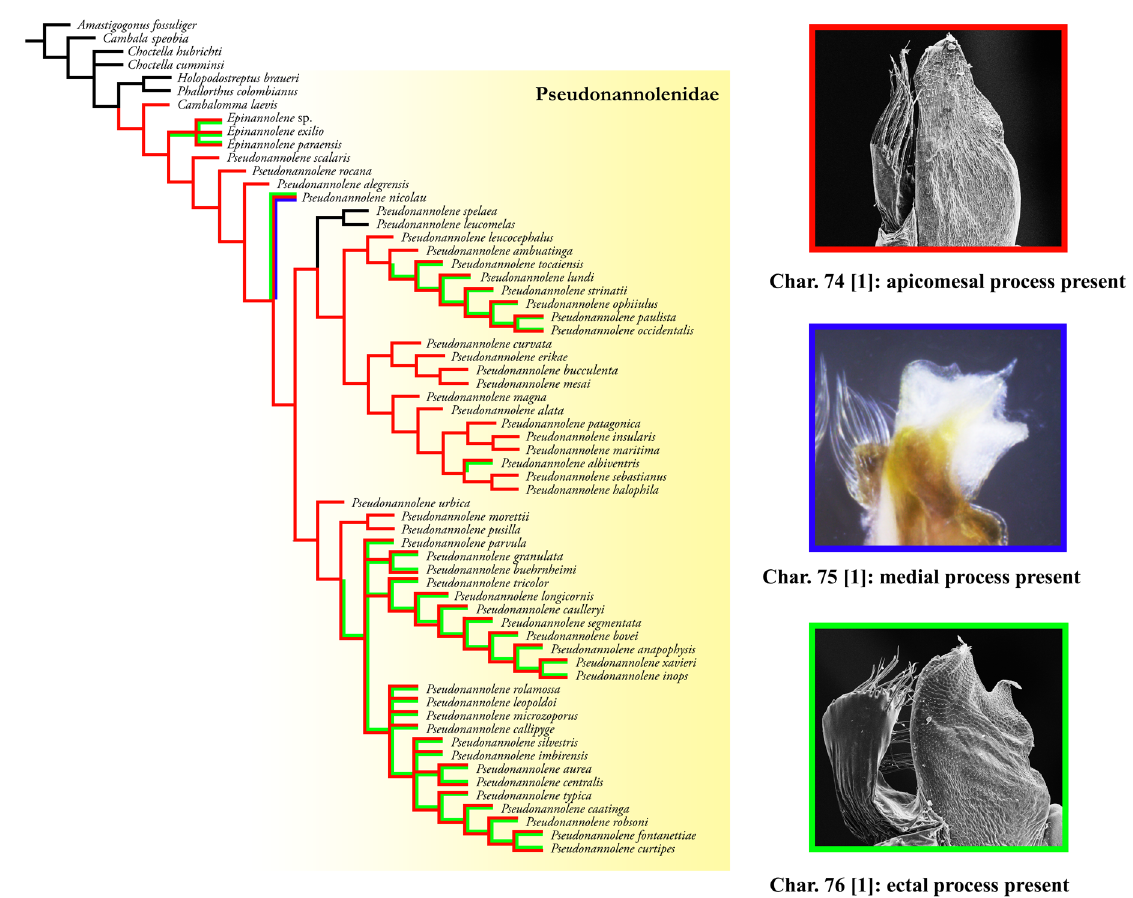
Fig. 11. Evolution of the processes on solenomere. Mapping on the strict consensus of 27 equally parsimonious trees under implied weighting ( k = 4–7). Images of solenomere: red = Pseudonannolene mesai Fontanetti, 2000 (IBSP 816); blue = P. nicolau sp. nov.; green = P. caatinga Iniesta & Ferreira, 2014 (IBSP